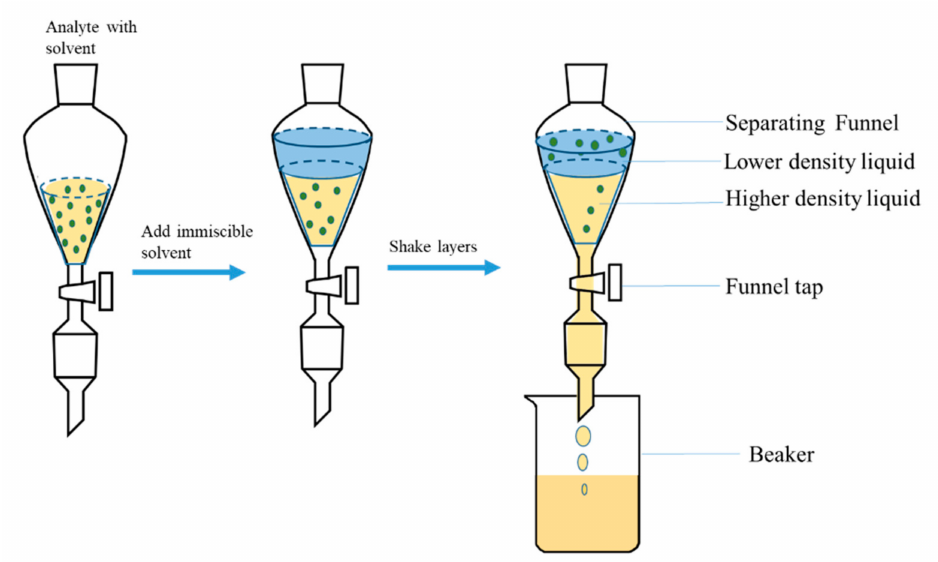
Figure 1. Diagrammatic illustration of liquid-liquid extraction (adapted from Nichols